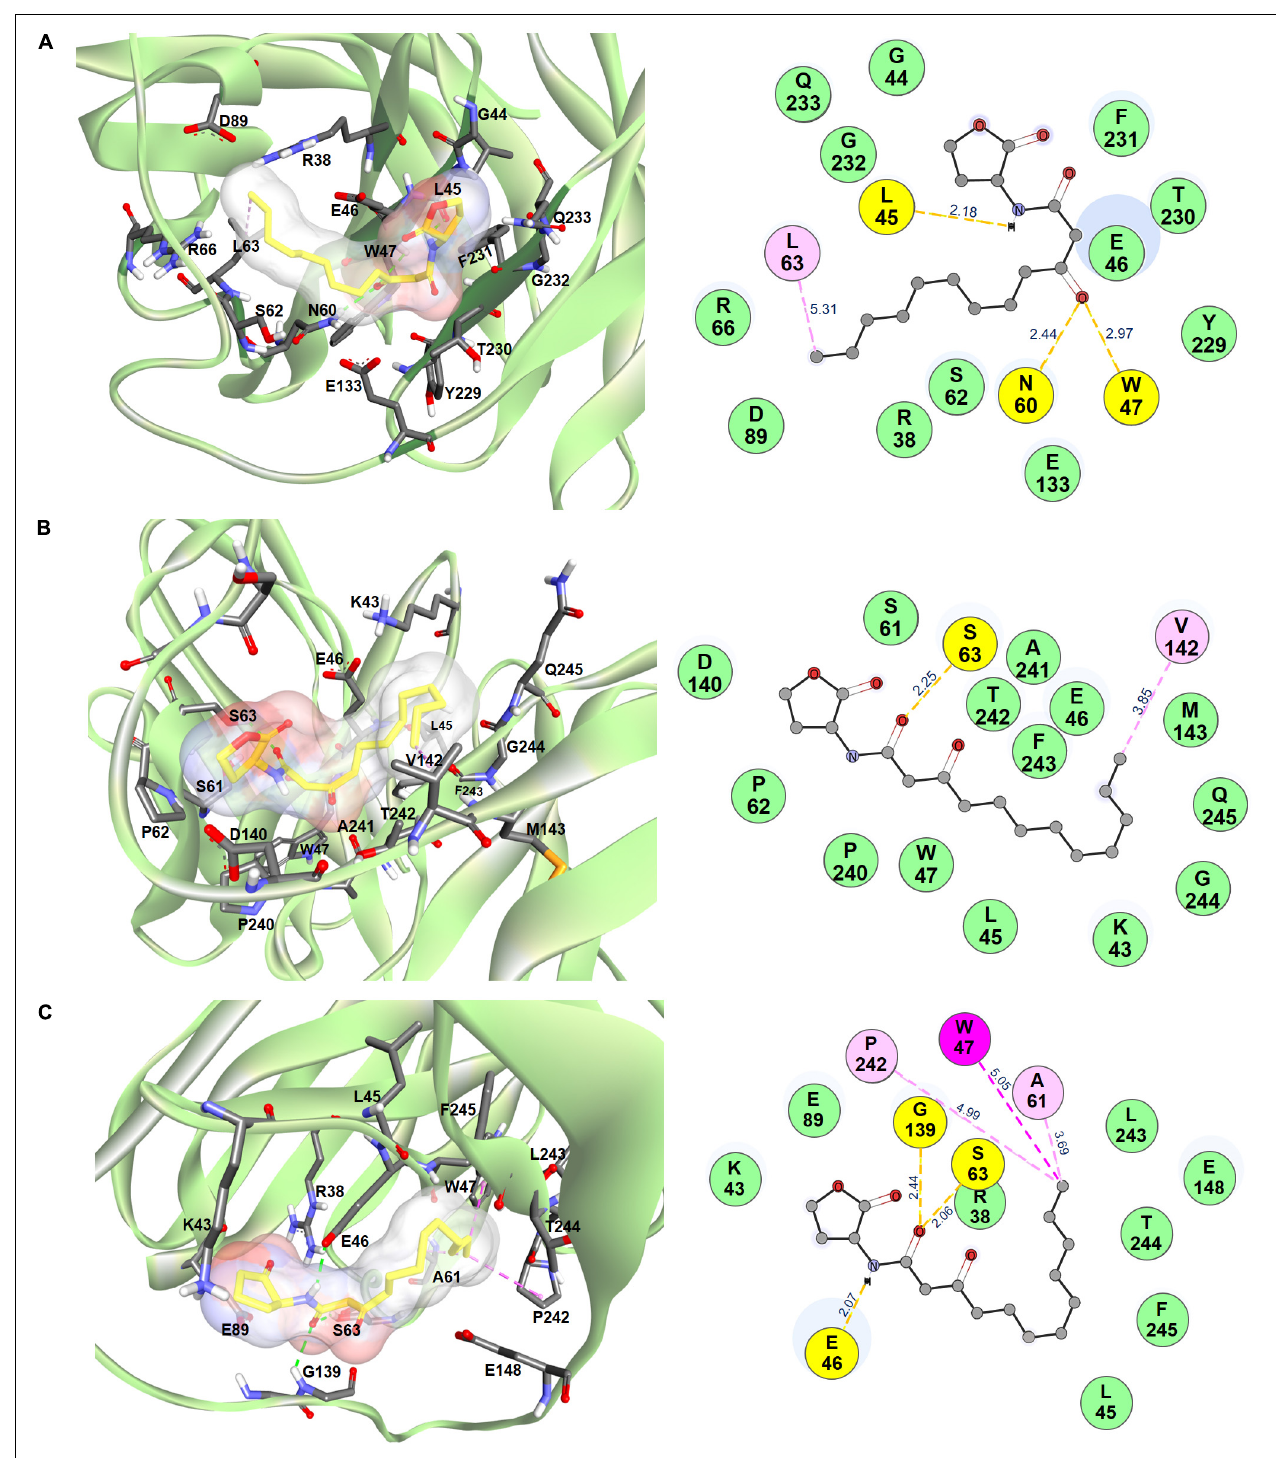
FIGURE 2 | Computerized contact interfaces between 3O-C12-HSL and HuscFvs. (A–C) on the left side of the panels show interaction between 3D structures of 3O-C12-HSL (yellow stick) and green ribbons of (A) HuscFv-E44, (B) HuscFv-F15, (C) HuscFv-F19. Right side of the panels (A–C) show residues of the respective HuscFvs and the HuscFv-3O-C12-HSL interactive bonds (yellow, hydrogen bond; light pink, alkyl; magenta, Pi-alkyl; green, van der Waals force).